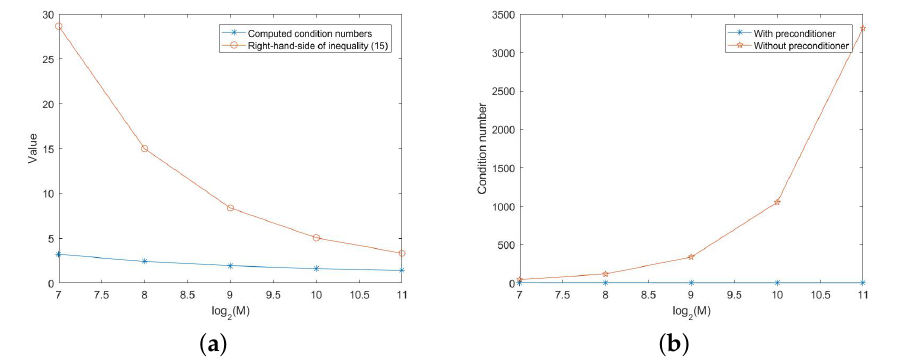
Figure 1. Eigenvalues distribution: ( a ) eigenvalue of coefficient matrix M ; ( b ) eigenvalue of precondi- tioned matrix P − 1 M .